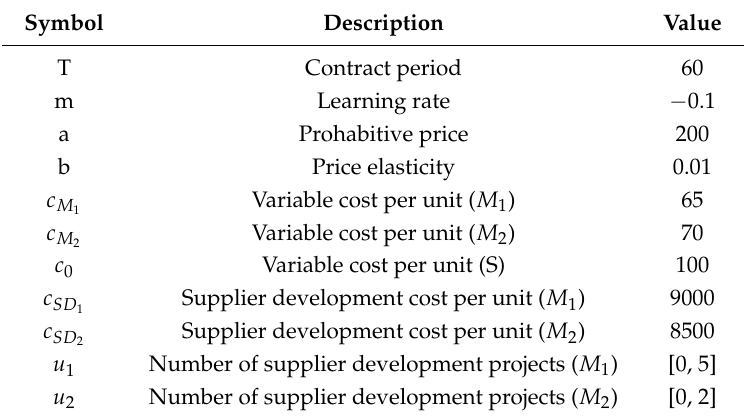
Table 1. List of parameters (Worthmann et al. 2016 [7]; Proch et al. 2017